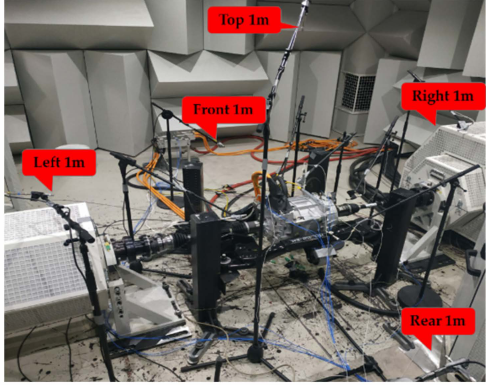
Figure 7. Noise Test of Permanent Magnet Synchronous Motor.